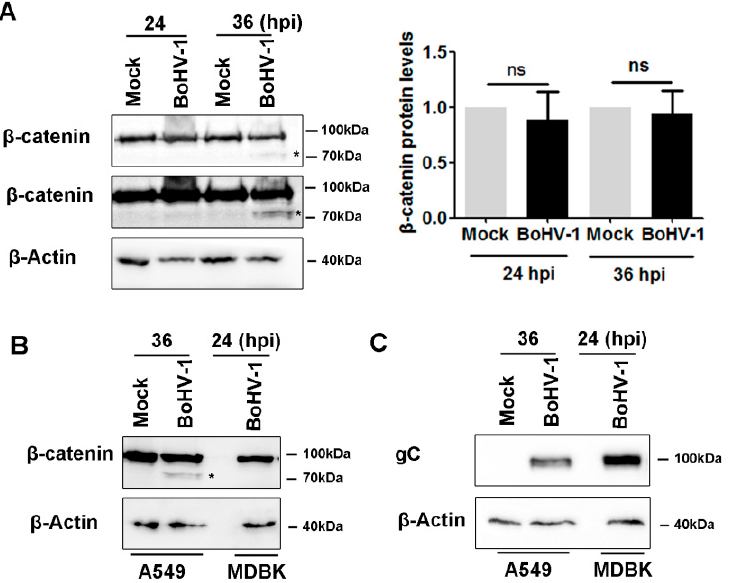
Figure 4. Detection of β -catenin protein levels in response to BoHV-1 infection in A549 cells. ( A ) A549 cells in 60 mm dishes were either mock-infected or infected with BoHV-1 at an MOI of 0.1 for 24 and 36 h. The cell lysates were prepared and subjected to Western blot analysis to detect protein levels of β -catenin. The immunoblots were developed with a normal exposure time (upper panel) and an extra-long exposure time (middle panel). The asterisk (*) denotes a faint band that was detected with the β -catenin antibody. The band intensity of β -catenin was initially normalized to β -Actin, and the fold change after virus infection was calculated by comparison to the uninfected control that was arbitrarily set as 1. Images represent the data from three independent experiments. Data shown in the right panel are the means ± SD of the three independent experiments. Statistical analyses were performed using Student’s t -test (ns, not significant; * p < 0.05). ( B , C ) A549 cells and MDBK cells in 60 mm dishes were either mock-infected or infected with BoHV-1 (MOI = 0.1) for 36 and 24 h. The cell lysates were subjected to Western blot analysis to detect either β -catenin ( B ) or viral protein gC ( C ). The asterisk in panel C denotes a band with a molecular weight less than that of β -catenin that was detected with the β -catenin antibody. Data shown represents the data of three independent experiments.